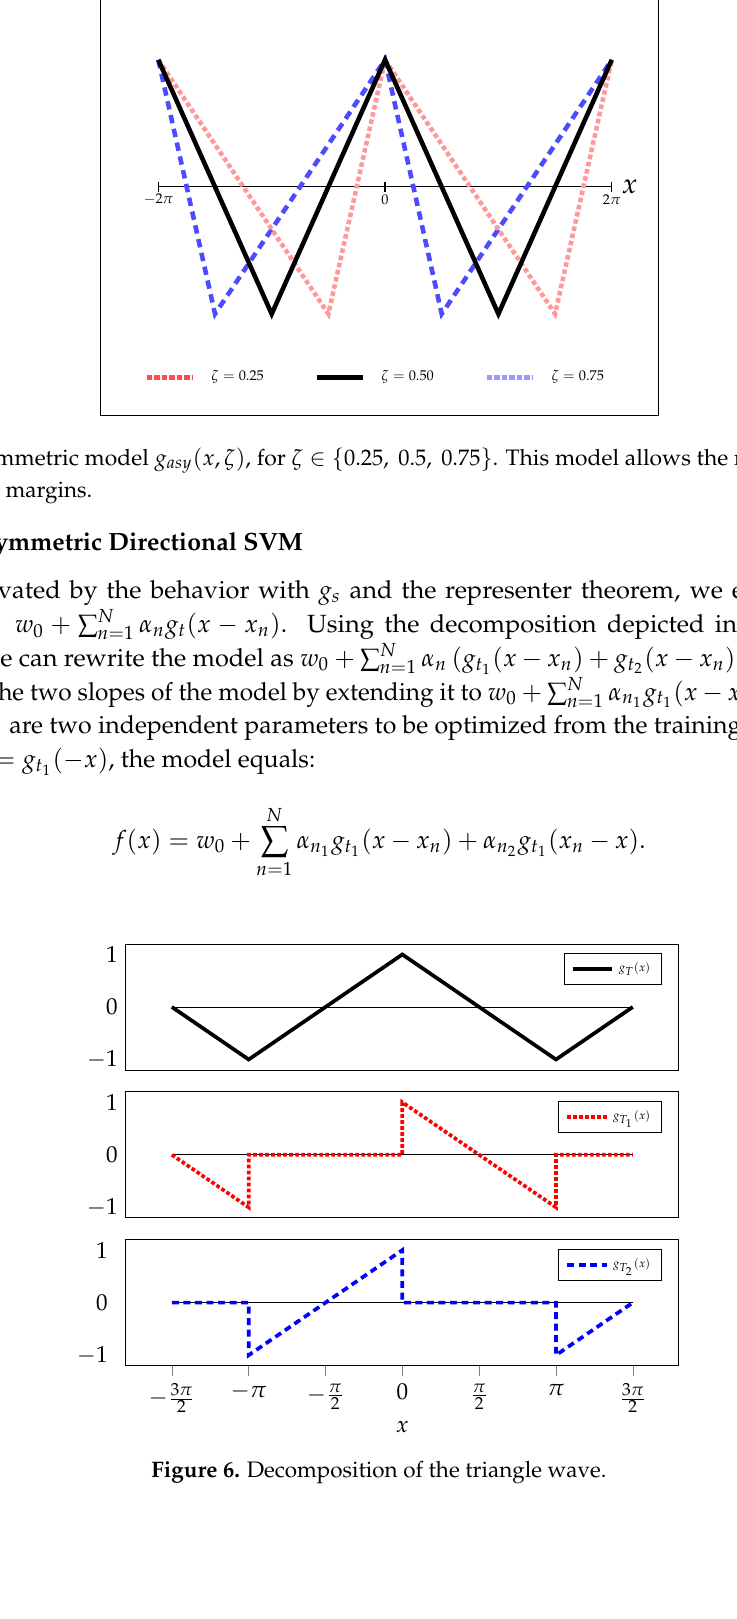
Figure 6. Decomposition of the triangle